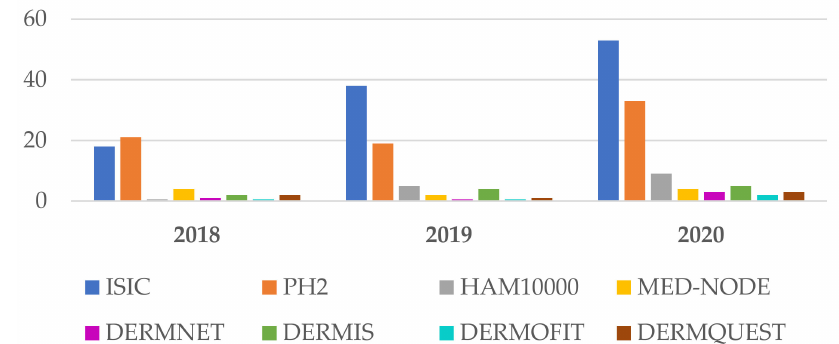
Figure 5. Frequently DSs used in Me detection between 2018 and 2020.